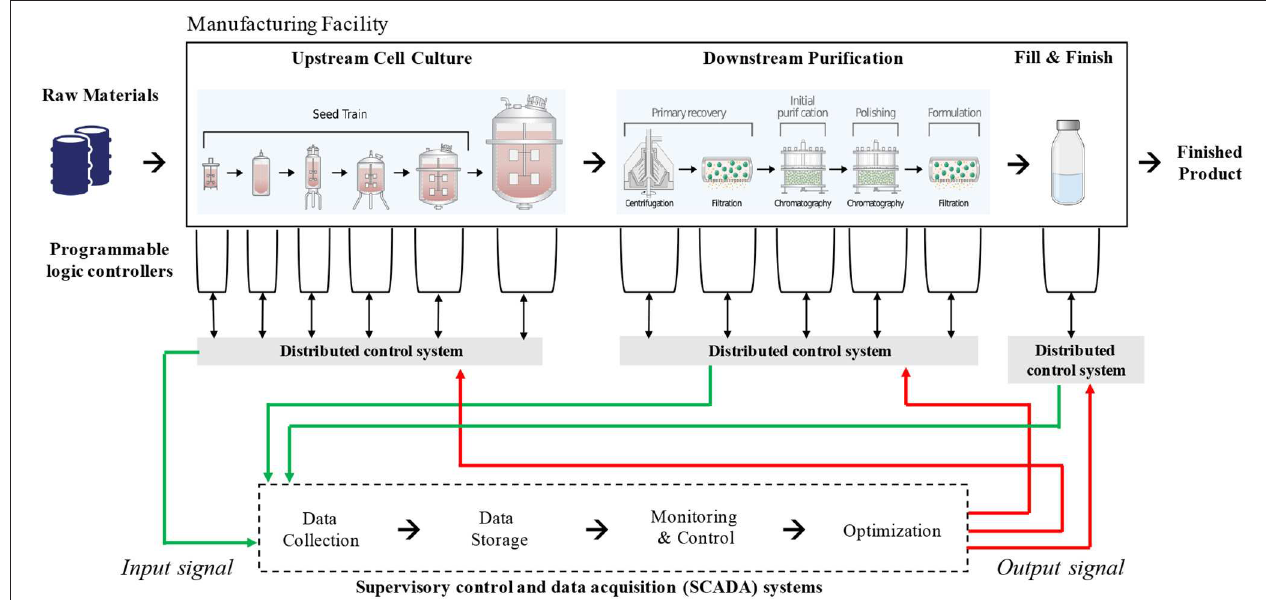
FIGURE 1 | Information flow in typical biomanufacturing operations for the production of monoclonal antibodies. The schematic indicates various cyber-physical systems that interact with each other to maintain process control. The data generated and processed by the SCADA is largely confined within a manufacturing facility.